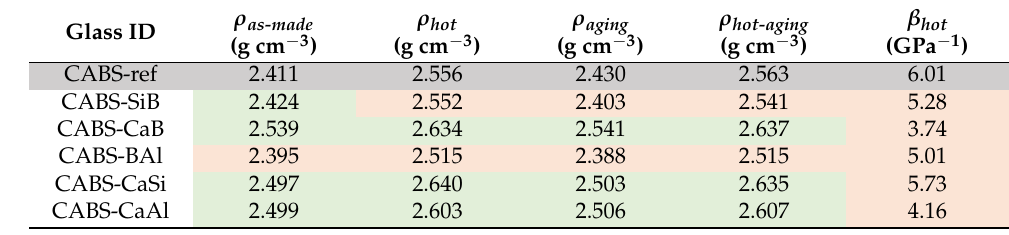
Table 3 indicates the composition and the post-treatment dependence of